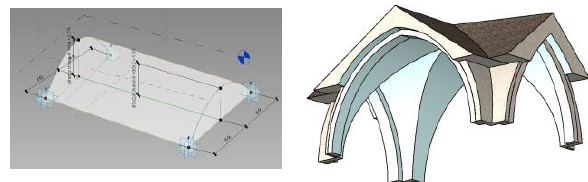
Figure 15. Parametric modelling of a vault (left), generic model of a cross-vault